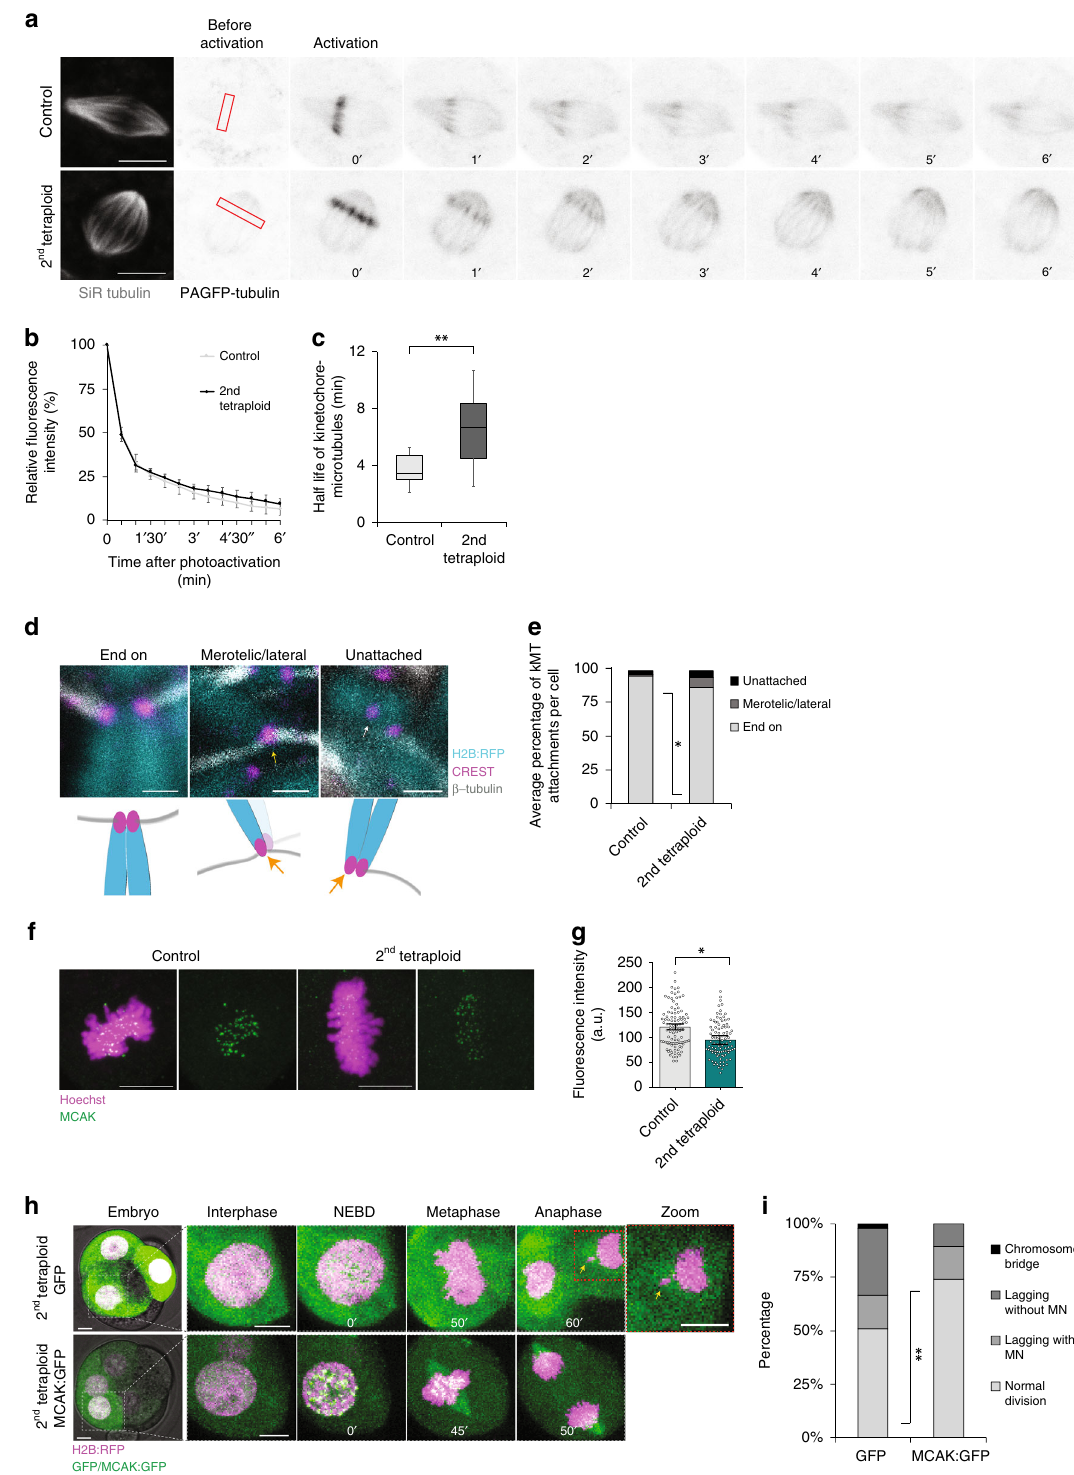
Imaging analysis and statistics . All image processing and analysis was performed using IMARIS 9.3. For MCAK fl uorescence intensity analysis in Fig. 5f, g, background-subtracted fl uorescence intensity values were obtained from a total of using ImageJ/Fiji 61 . No thresholding or masking was applied to the images and LUT 100 kinetochores analysed from 10 embryos (10 kinetochores per embryo) for each brightness varies linearly. For centromere tracking in Fig. 4a, b, manual tracking was group and statistical analysis was performed as an inter-embryo comparison using performed using the “ Manual Tracking with TrackMate ” feature of TrackMate the average fl uorescence intensity per embryo. All measurements analysed in this plugin 62 on Fiji. For metaphase plate width measurements in Fig. 4c, d, the distance study were taken from distinct samples and samples were not measured repeatedly. between two lines drawn across each side of the metaphase plate was measured. The Data were analysed using GraphPad Prism 7 software (GraphPad Software, La Jolla, lines were drawn based on the MajSatTALE:mClover fl uorescent signal and CA, USA, www.graphpad.com). Shapiro – Wilk normality tests were applied where delimited the area occupied by all aligned chromosomes. Three dimensional appropriate and either unpaired two-tailed t tests or two-tailed Mann – Whitney tests reconstructions (Supplementary Fig. 5b; Supplementary Movies 1 – 3) and surface were applied. Statistical signi fi cance was considered when P <0.05. rendering (Supplementary Fig. 5b and Supplementary Movie 3) were generated NATURE COMMUNICATIONS| (2019) 10:4834